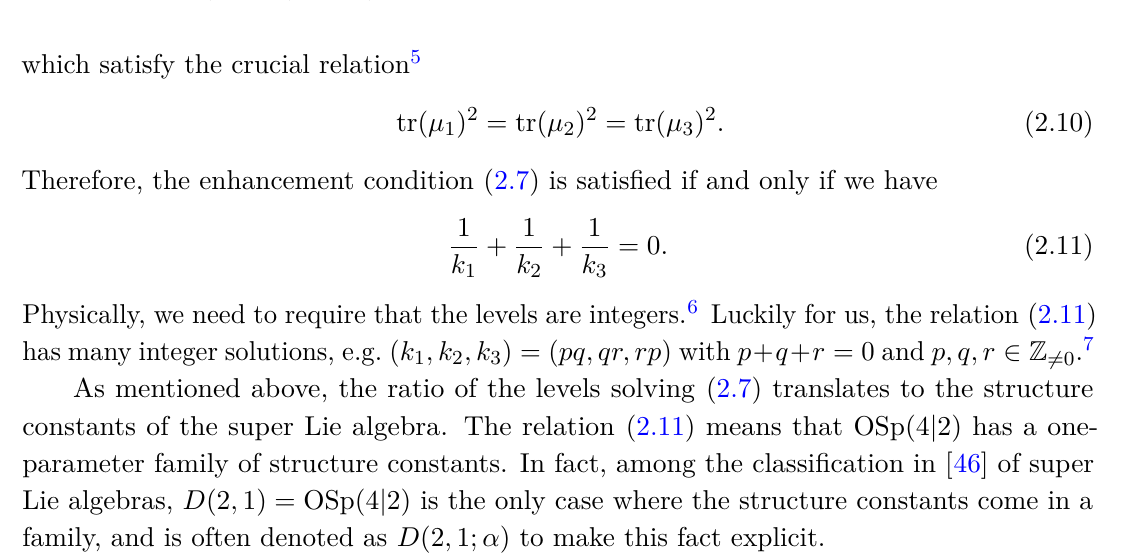
Figure 1 . T N theory gauged with SU( N ) k to N = 4 when 1 /k